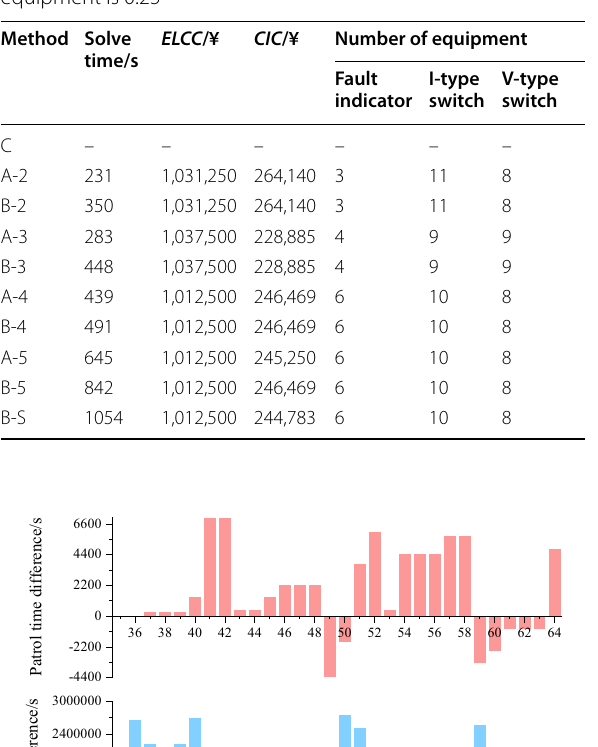
Table 12 Solution results when the failure probability of single equipment is